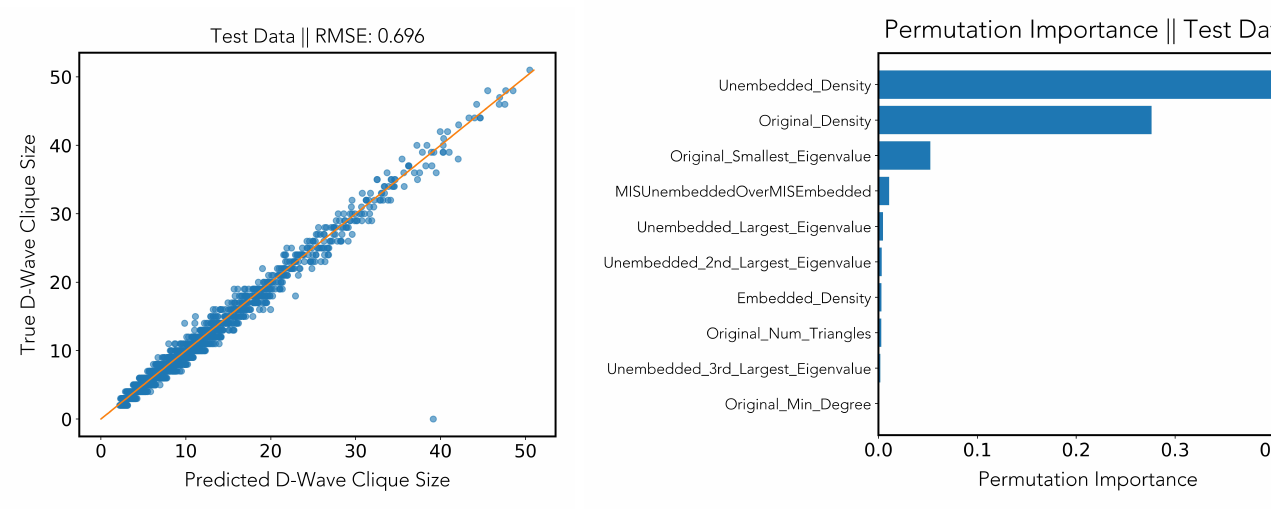
Figure 3. Regression via gradient boosting. ( Left ): predicted D-Wave clique size vs. true D-Wave clique size. ( Right ): permutation importance ranking. Setting of fixed annealing time and fixed UTC